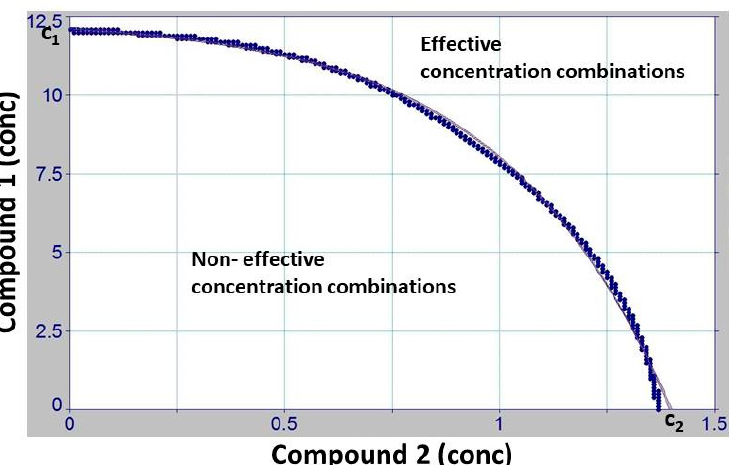
Figure 4. Discussion of the OPECC ( Optimal Point of Effective Concentration Combination ) calculation process. This is an example of a binary combination (CHX–BAC) for which no OPECC is directly determinable because this zero curve, representing the shift from non-effective to effective concentration pairs, is a strictly decreasing function without sign change of the derivation and, therefore, has no inflection point. In this case, the search for an optimal concentration pair is naturally still reduced to the blue line in Figure 3, shown here as a thin black line. If no further influencing constraints or factors are available, one of the single boundary concentration combinations ((C 2 ; 0) or (0; C 1 )) can then be taken as the OPECC.